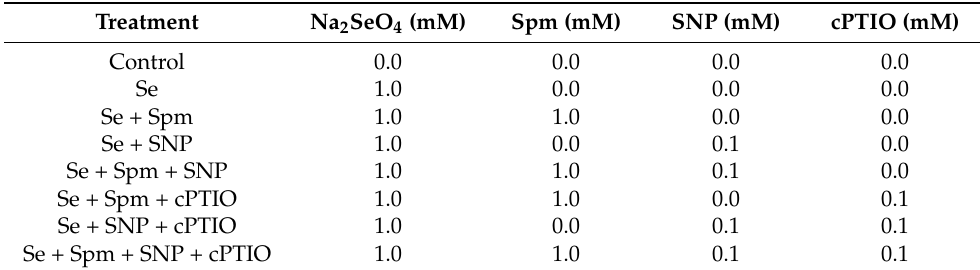
Table 1. Foliar treatments used in this